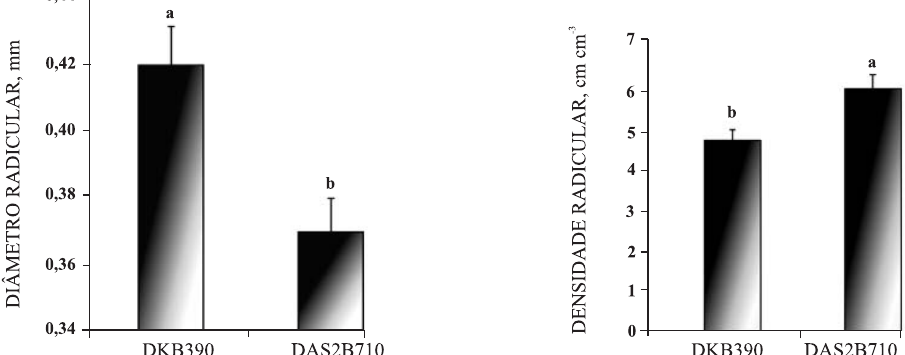
Figura 10. Diâmetro e densidade radicular das cultivares de milho DKB 390 e DAS 2B710 na profundidade de 20–30 cm de um Latossolo Vermelho. As barras referem-se aos erros-padrão das